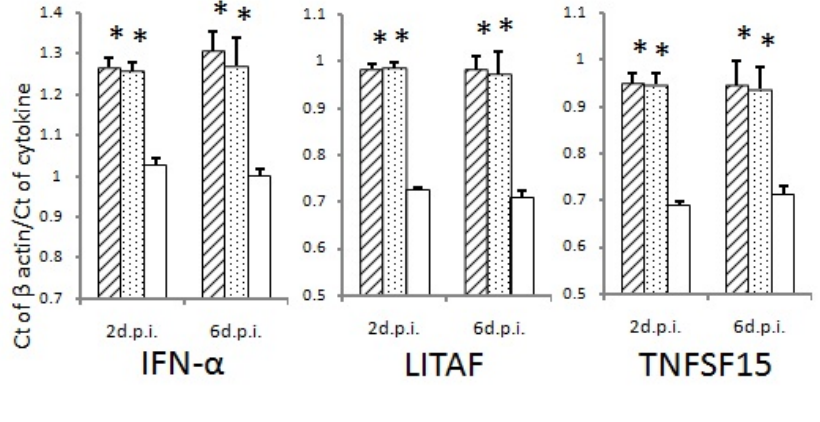
Figure 7. Cytokine and transcription factor mRNA levels in the hearts of 2-day-old chicks inoculated with WNV 6-LP or 6-SP. Chicks were infected with 10 2 PFU of virus administered subcutaneously in the femoral region, and tissues were collected at 2 and 6 d.p.i. Total RNA was then extracted and cDNA synthesized. SYBR Green-based quantitative real-time PCR was performed using the synthesized cDNA. Relative quantification of cytokine gene expression was done using the CT method. The CT data for each cytokine were normalized against the b-actin levels in the same sample. * and ** indicate statistically significant differences ( * p , 0.01; ** p , 0.05) in cytokine and transcription factor mRNA levels compared with mock-infected